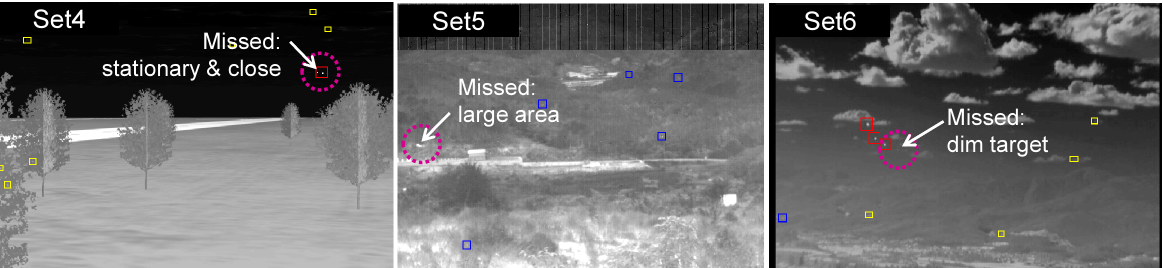
Figure 26. Examples of failure cases of the proposed